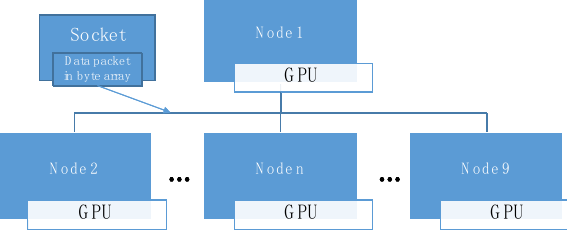
Fig. 5. The architecture of the communication model among 9 different nodes. And n is a number of node and it ranges from 3 to 8. The customized data packet send/receive is based on socket between